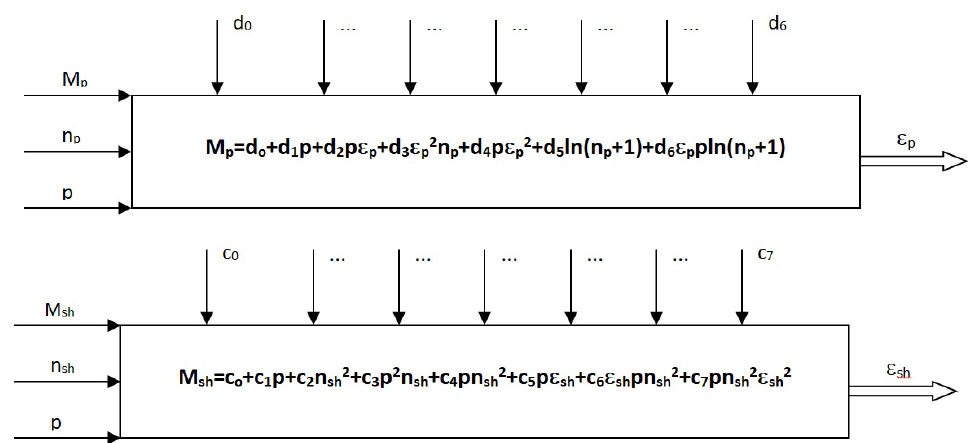
Figure 8. Block diagram of equations describing shaft torque of hydrostatic pump and engine, where p is the pressure in the system, n p is the rotational speed of the hydrostatic pump, n sh is the rotational speed of the hydrostatic engine, M p is the shaft torque of the hydrostatic pump, M sh is the shaft torque of the hydrostatic engine and d 0 . . . d 6, co . . . c 7 are constants [2]. A regression function (Figure 9) is used to calculate the capacity Q p of the hydrostatic pump and the displacement Q sh of the hydrostatic engine.